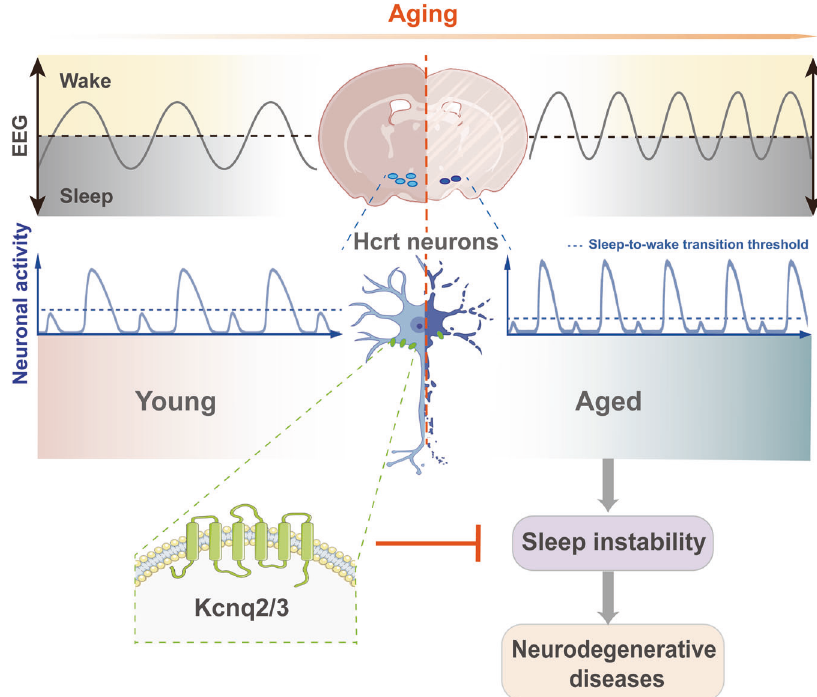
Fig. 1 Role of the hyperexcitable Hcrt neurons in aging-related sleep instability and neurodegenerative diseases. Aged mice exhibit more frequency of sleep-wake transition, along with elevated excitability of Hcrt neurons compared with young mice. Kcnq2/3 channels in Hcrt neurons could be a promising therapeutic strategy to improve sleep continuity in the aged, thereby preventing neurodegenerative